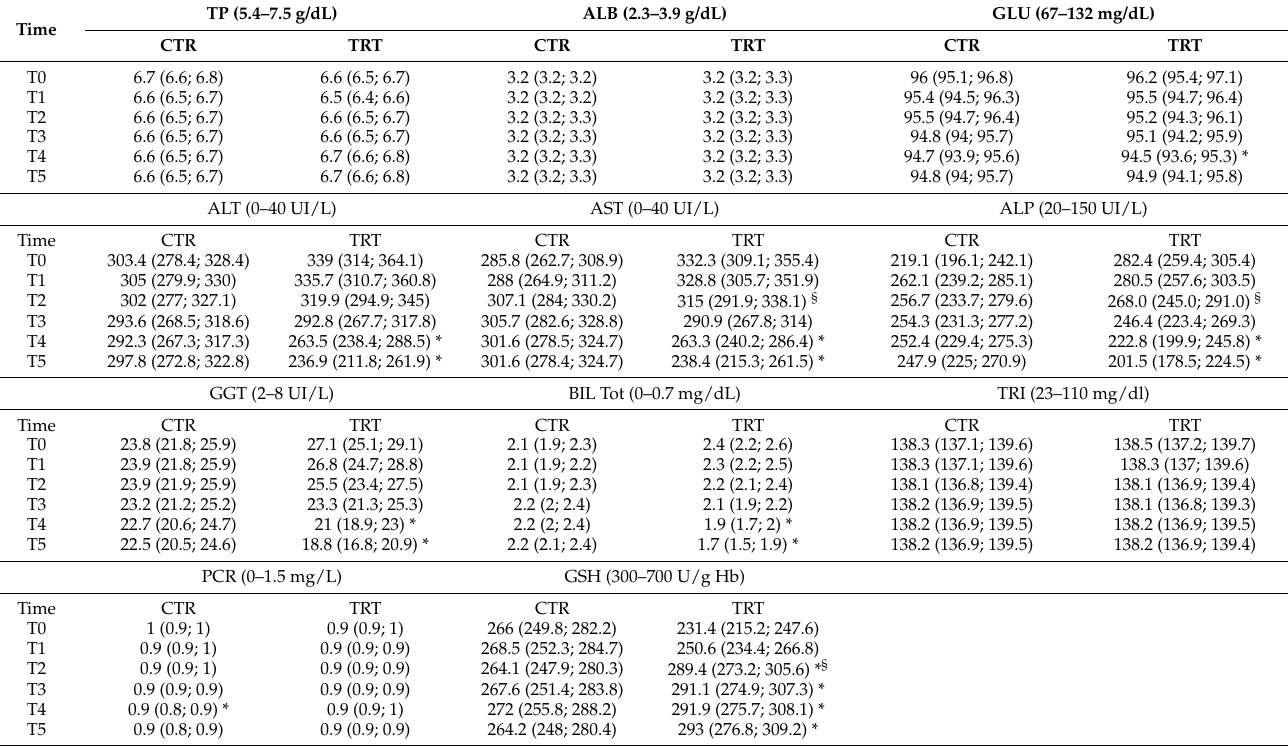
Table 2. Mean and 95% Confidence Interval (95% CI) resulted from the biochemical analyses (total proteins (TP), albumins (ALB), glucose (GLU), alanine transaminases (ALT) alanine aminotransferases (AST), alkaline phosphatases (ALP), gamma-glutamyl transferase (GGT), bilirubin (BIL), triglycerides (TRI), c- reactive protein (PCR), and erythrocyte glutathione concentration (GSH)) in the control (CTR) and treated (TRT) group in the study period. Times: T0 (day 0), T1 (day 7), T2 (day 14), T3 (day 21), T4 (day 28), and T5 (day